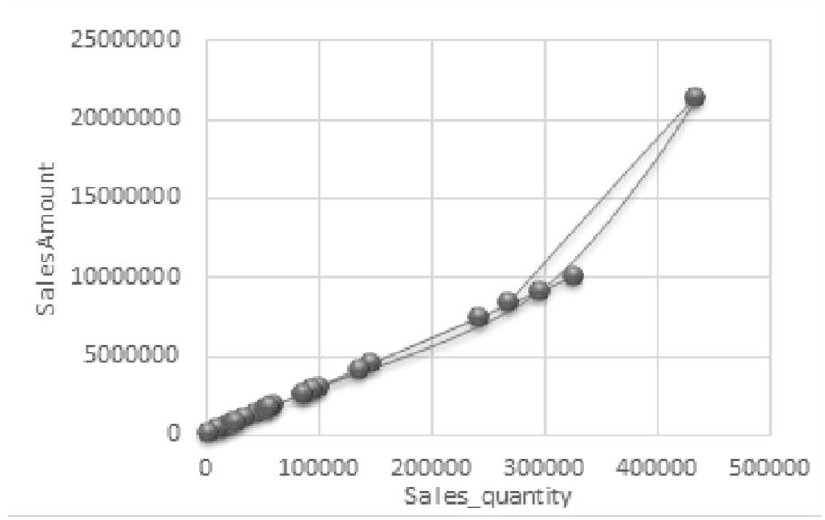
Figure 3: Scatter plot to check linearity